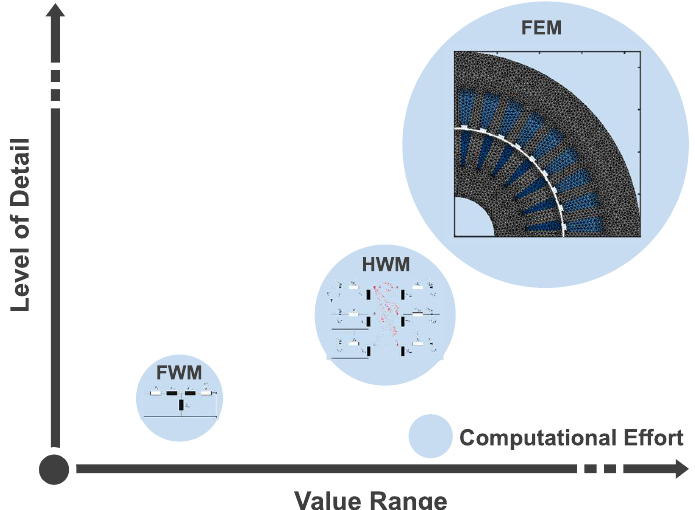
Figure 1. Classification of IM models with respect to value range, level of detail, and computational